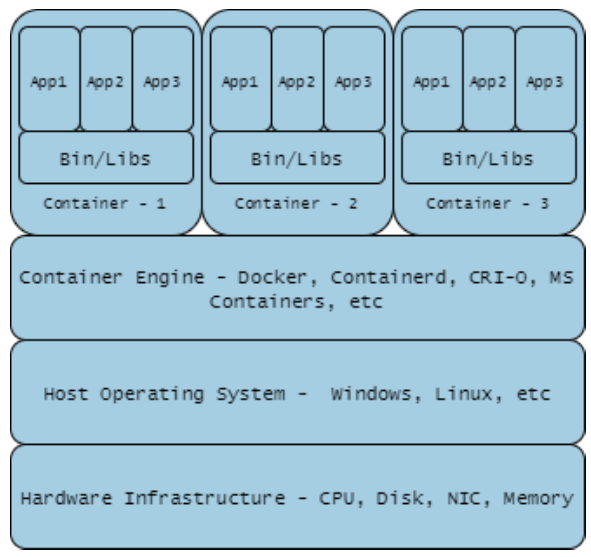
Figure 11. Containerisation Technology.